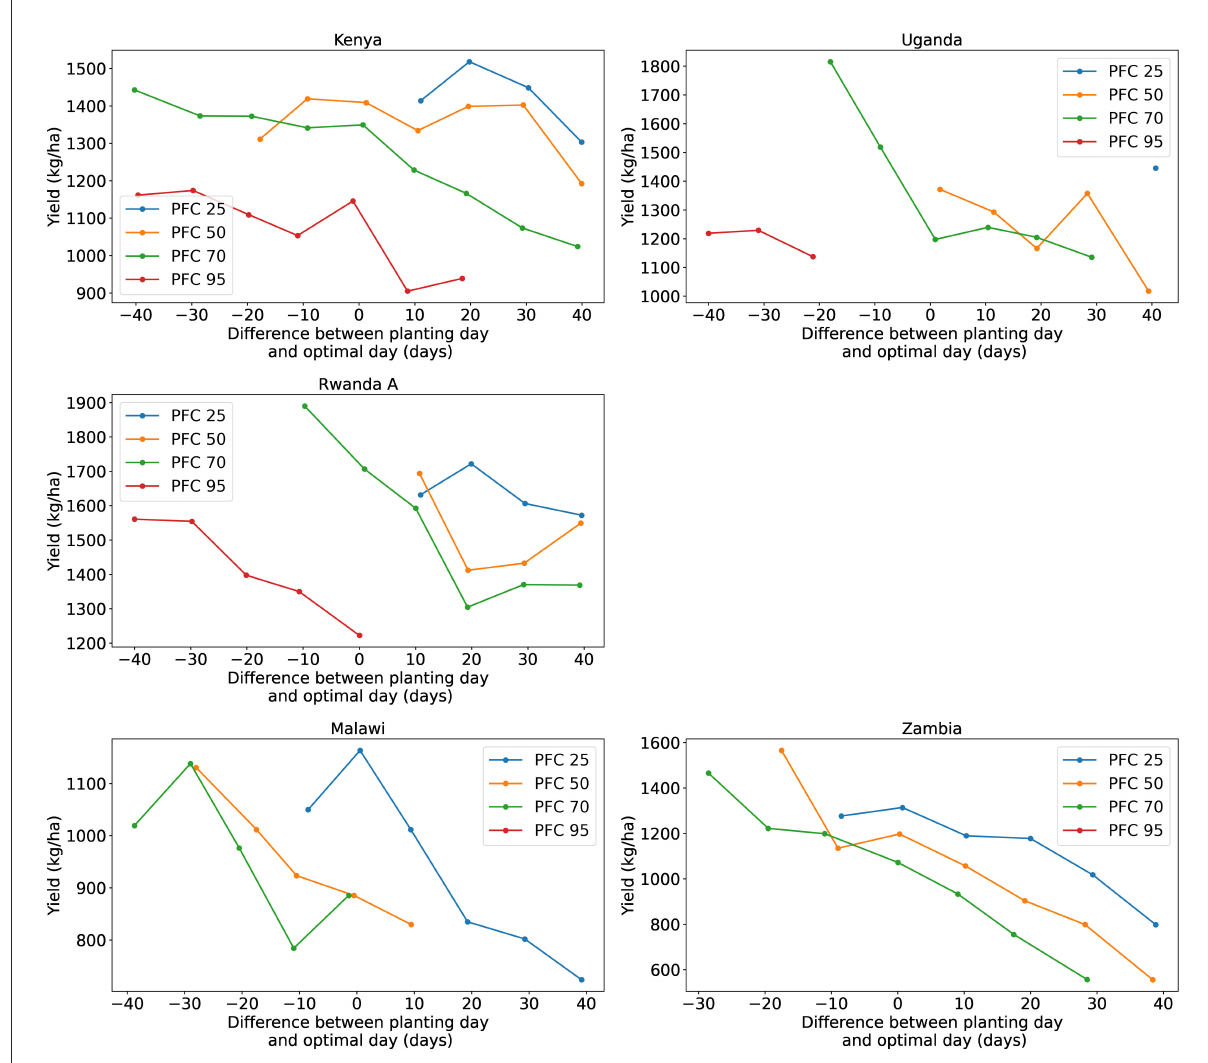
FIGURE5 Yield plotted against the difference between the actual and recommended planting time for all countries and seasons for PFC threshold criterion ranging from 25 to 95%.